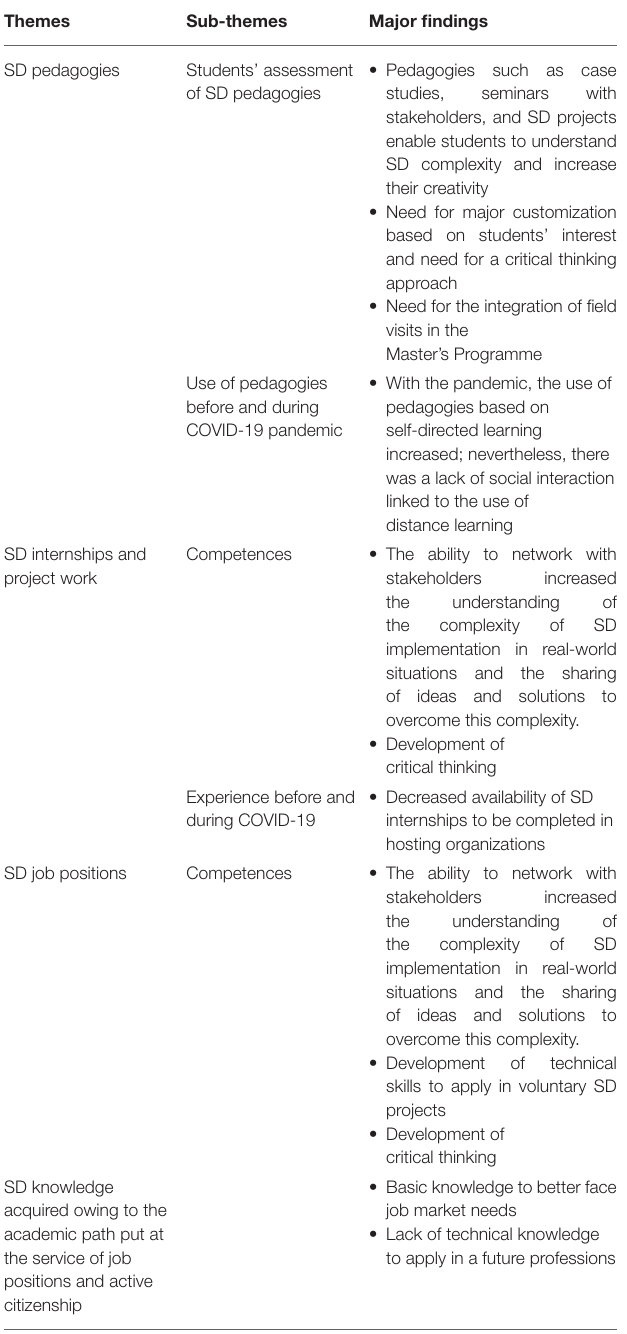
TABLE 3 | Themes, sub-themes, and findings of the interviews’ content